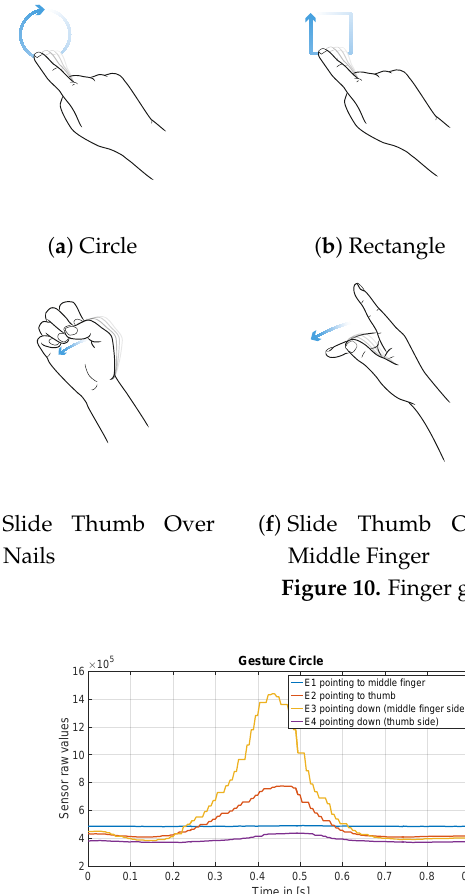
Figure 11. Raw values of the capacitive sensor for gestures Circle and